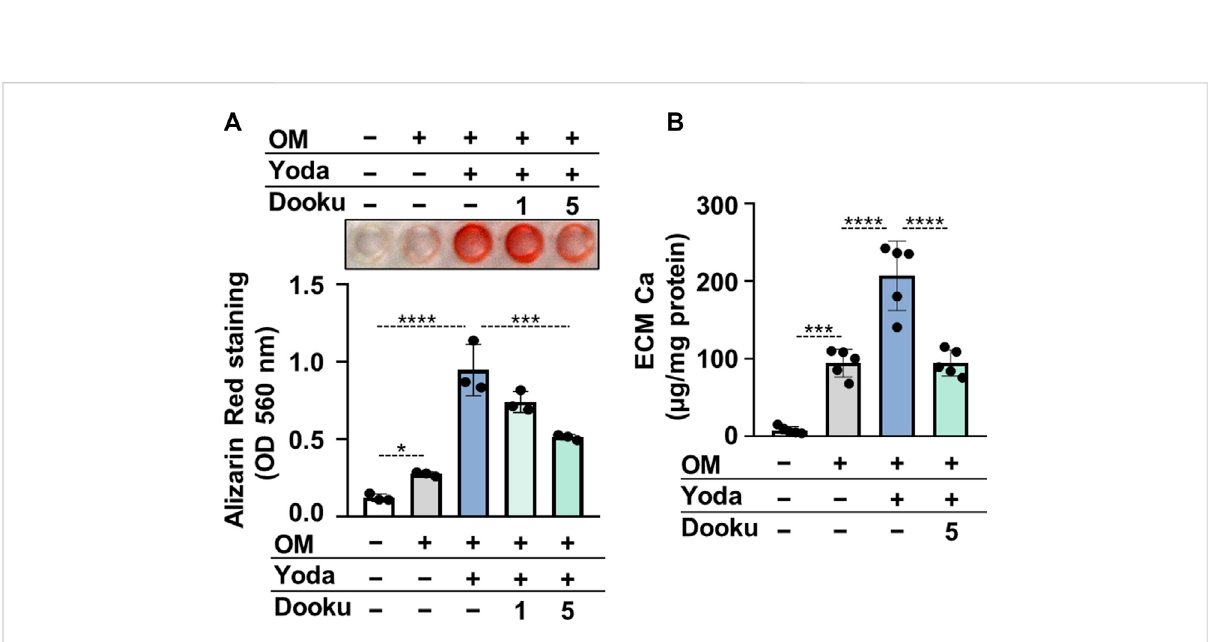
FIGURE 5 Dooku1 inhibits Yoda1-induced increase in HAoSMCs calci fi cation. (A,B) HAoSMCs were exposed to OM (OM; excess P i : 1.5 mmol/L, excess calcium: 0.6 mmol/L) in the presence or absence of Yoda1 (10 μ mol/L) and Dooku1 (1 or 5 μ mol/L). (A) Representative Alizarin Red staining (day 6) and quanti fi cation. (B) Calcium content of HCl-solubilized ECM (day 6). Data are presented as mean ± SD, n = 3 – 5. * p < 0.05, *** p < 0.005, **** p <